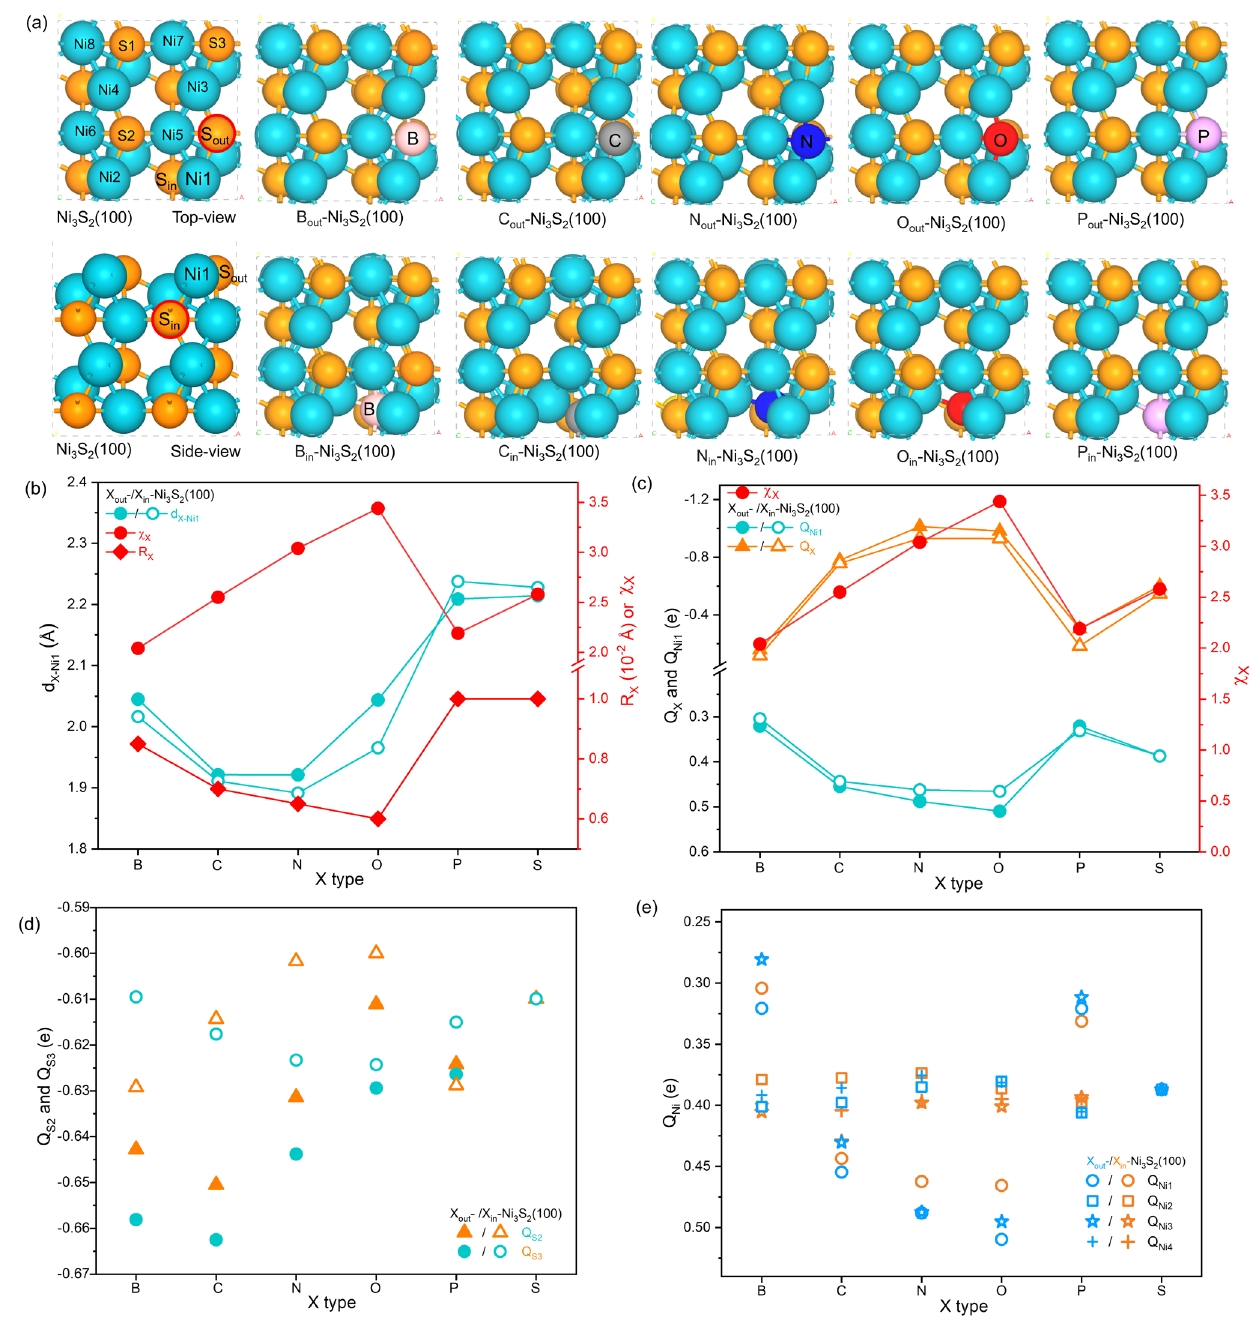
Figure 1. ( a ) The structures of Ni 3 S 2 (100), X out -Ni 3 S 2 (100), and X in -Ni 3 S 2 (100) (surface Ni atoms are labeled as Ni1~Ni8, and Ni1~Ni4 represent top most Ni atoms, Ni5~Ni8 represent sublayer Ni atoms). ( b ) The bond length of X-Ni1 (d X-Ni1 ) corelates with the electronegativity ( χ x ) and atom radius (R x ) of X (S on horizontal axis represent pristine Ni 3 S 2 (100)). ( c ) Bader charge of Ni1(Q Ni1 ) and X(Q X ) correlate with χ x for both X out -Ni 3 S 2 (100) and X in -Ni 3 S 2 (100) systems. ( d ) The Bader charge of S2 and S3 atoms. ( e ) The Bader charge of Ni1~Ni4 atoms.